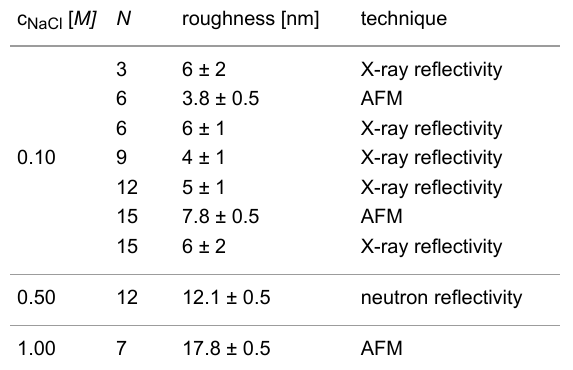
Table 1: Roughness for (PDADMAC + PSS) N multilayers at different ionic strengths (dry films). c NaCl [ M]